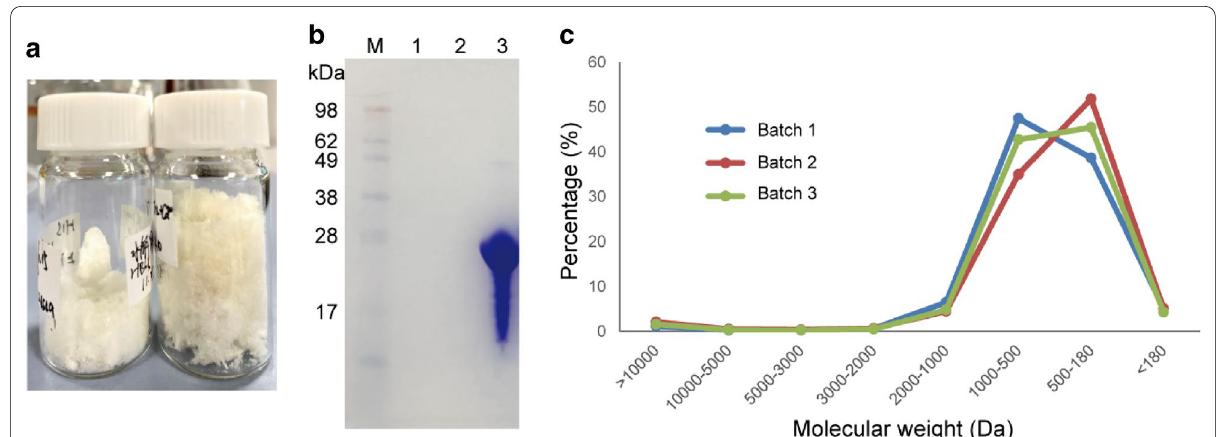
Fig. 6 Collagen hydrolysate (peptides) of RHLC and its molecular weight distribution. a Freeze-dried samples statement of hydrolytic peptides. b SDS–PAGE of collagen hydrolysate of RHLC. Lane 1 and 2 were the production of collagen hydrolysed peptides, line 3 was RHLC before hydrolyzation. c Molecular weight distribution of hydrolytic peptides that over 91% were between 180 and 2000 Da. Three batches of hydrolyzation had been